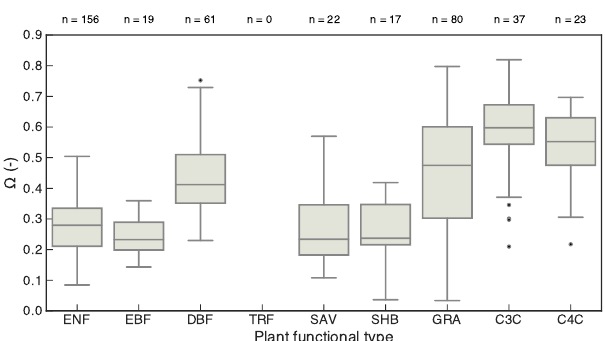
Figure A2. Box and whisker plot (line, median; box, inter- quartile range) showing the estimated coupling coefficient ( (cid:127) ) from FLUXNET data grouped by plant functional type. These data have been corrected for energy imbalance by adjusting the Bowen-ratio method for the imbalance across the three most productive months. Whiskers extend to 1.5 times the inter-quartile range, with dots out- side of the whiskers showing outliers. Plant functional types are defined as ENF – evergreen needleleaf forest, EBF – evergreen broadleaved forest, DBF – deciduous broadleaved forest, TRF – tropical rain forest, SAV – savanna, SHB – shrub, GRA – grasses, C3C – C 3 crops, and C4C – C 4 crops. Values of n indicate the num- ber of site years for